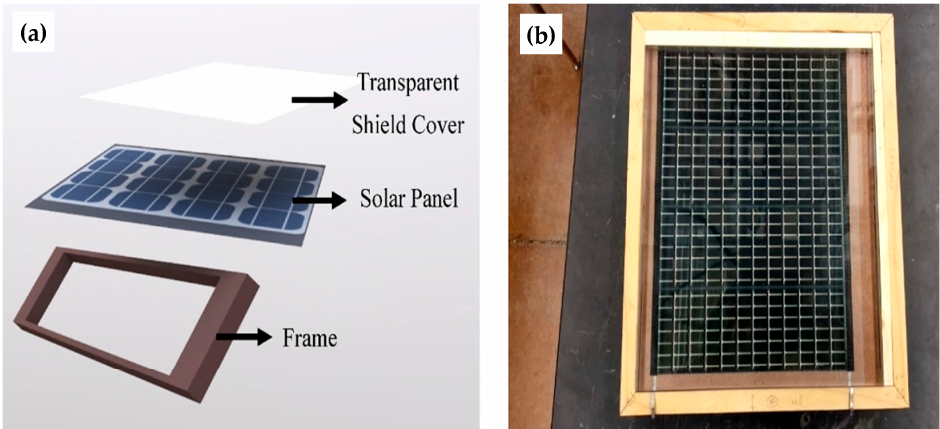
Figure 16. PV asphalt pavement block proposed by Hossain in 2021: ( a ) Three-layer model. ( b ) Proto- type (Reprinted with permission from Ref. [70]. 2021, MDPI)